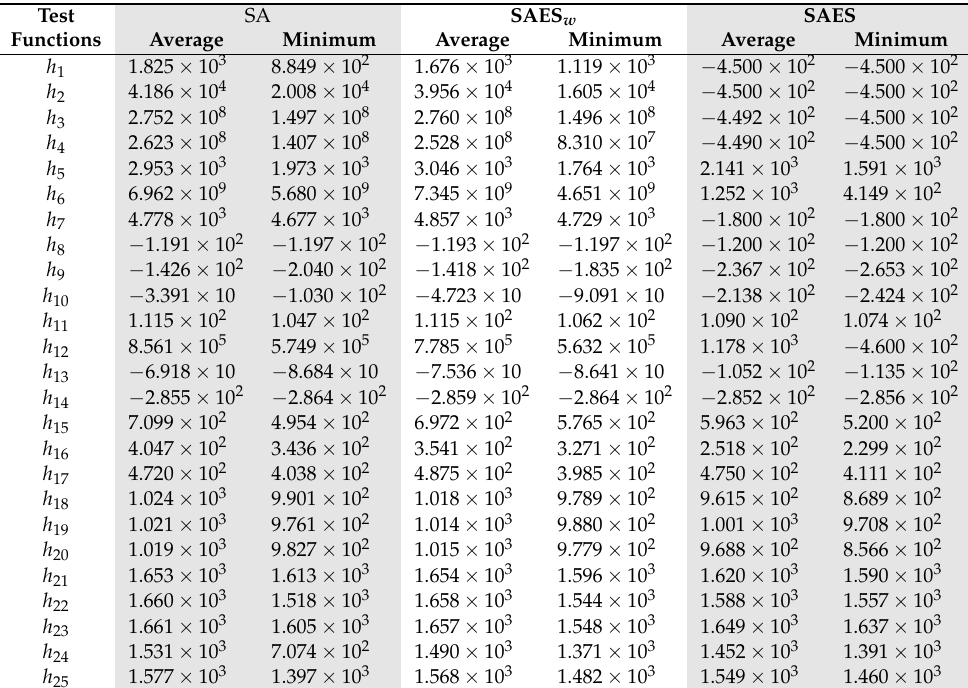
Table 3. Average and minimum objective function values obtained by the SA methods using the hard test functions with n = 30.